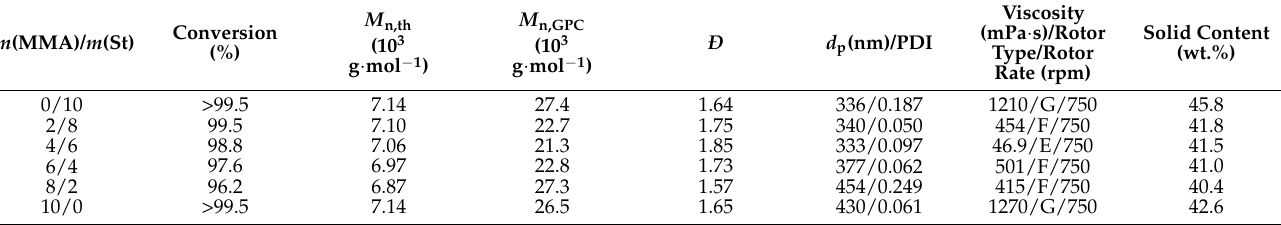
Table 6. Results of emulsion with MMA and St units in polymer chain.